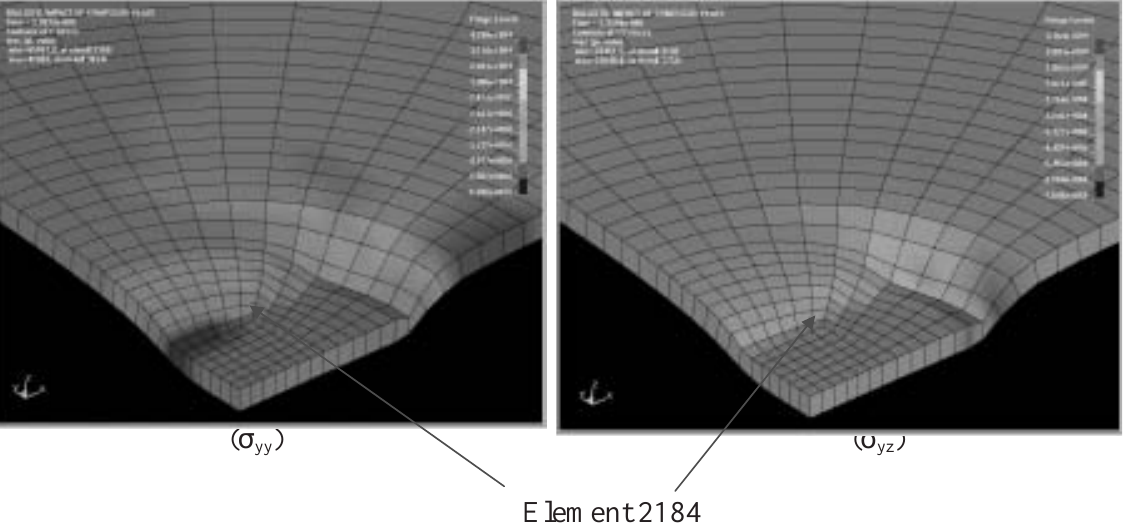
Fig. 8. σ yy and σ yz stress distributions on the top layer of the 1st ply at t = 3.0e-05s.